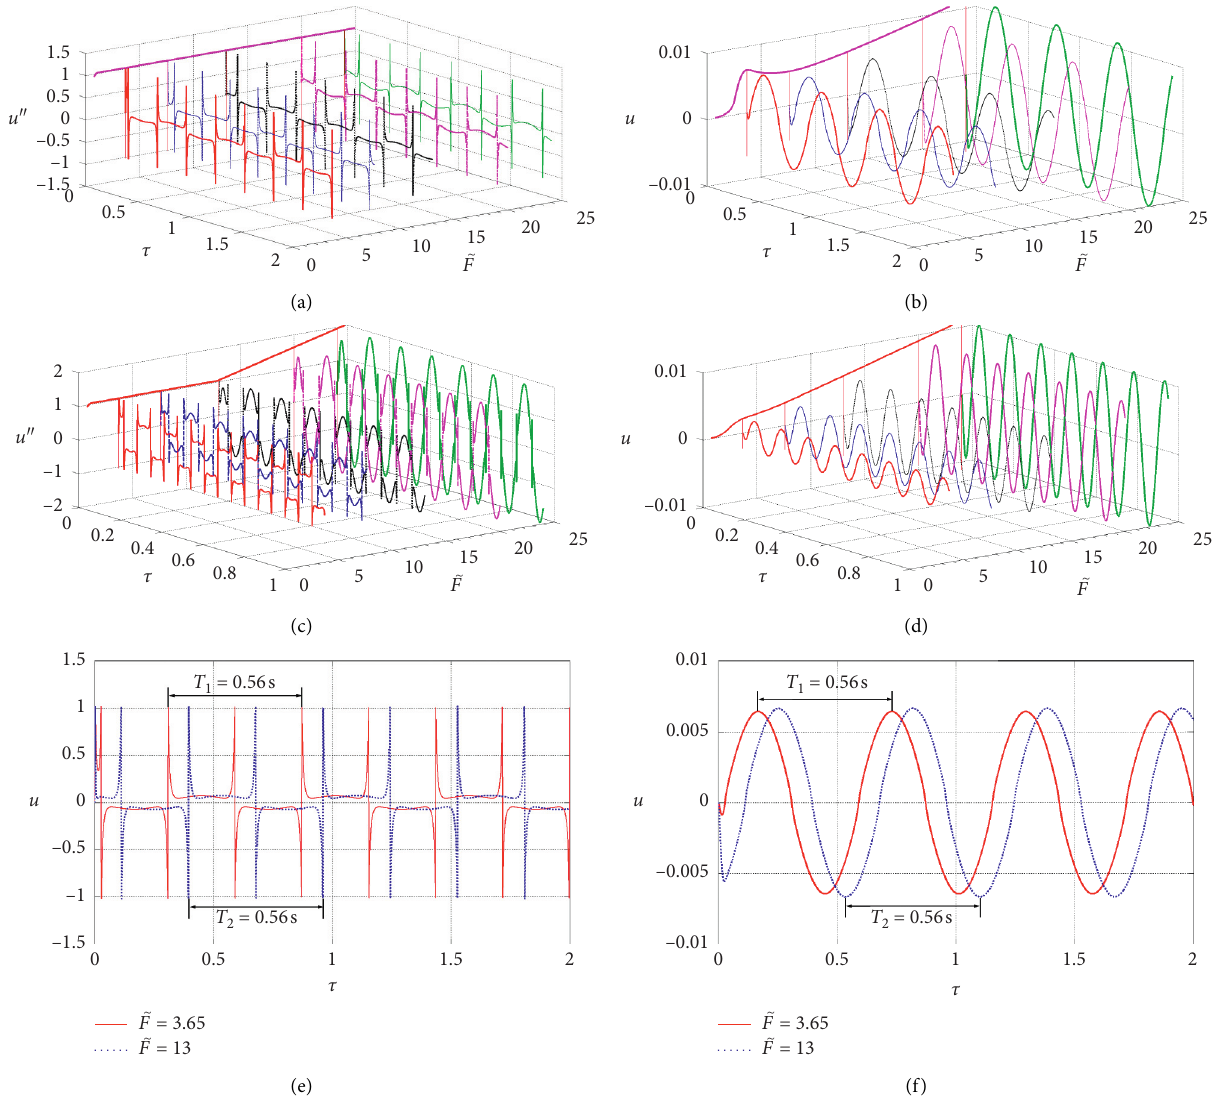
Figure 10: The influences of different Ω on shock response of the NSA ( 􏽥 A � 1, w � 200 π /s, μ � 6 . 7 × 10 − 4 ). (a) Absolute acceleration response. (b) The relative displacement